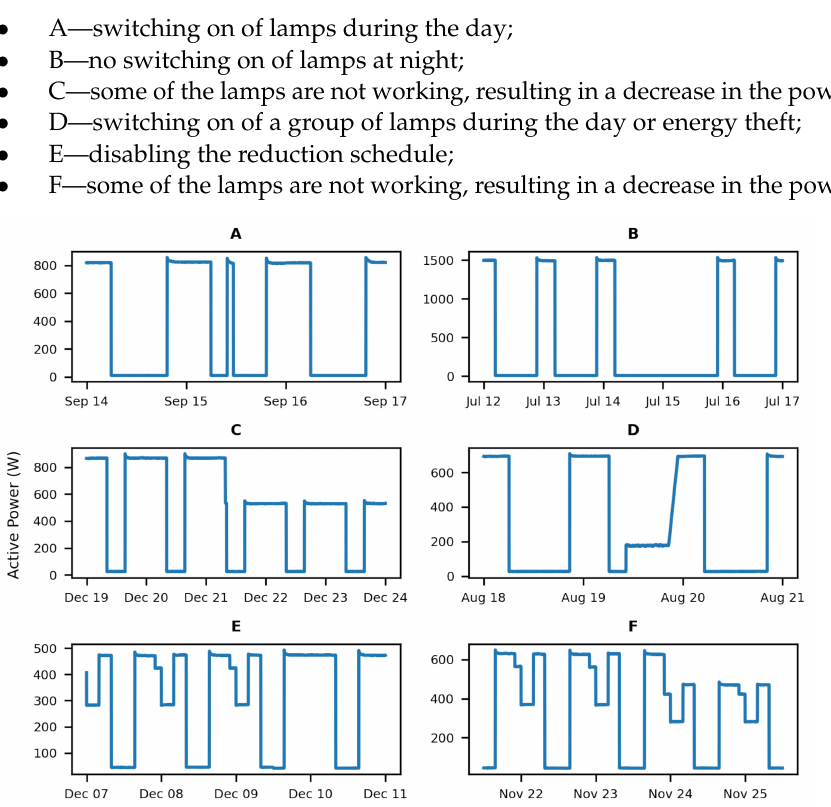
Figure 5. Examples of anomalies in energy consumption by the lighting system. Subfigures show examples of anomalies: ( A ) switching lamps on during the day; ( B ) no switching lamps on at night; ( C ) some of the lamps are not working; ( D ) switching a group of lamps on during the day; ( E ) disabling the reduction schedule; ( F ) some of the lamps are not